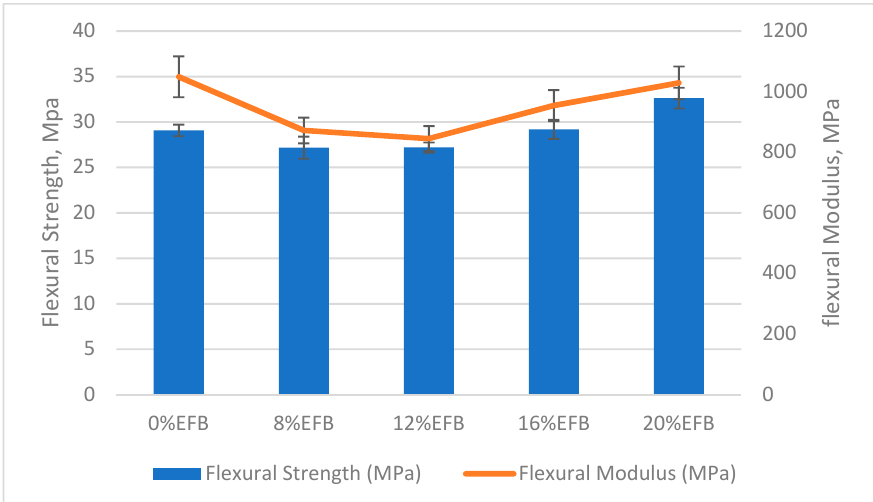
Figure 3. Flexural strength and flexural modulus of PBS composites. Table 2. Mechanical properties of PBS/starch/glycerol and EFB blends.